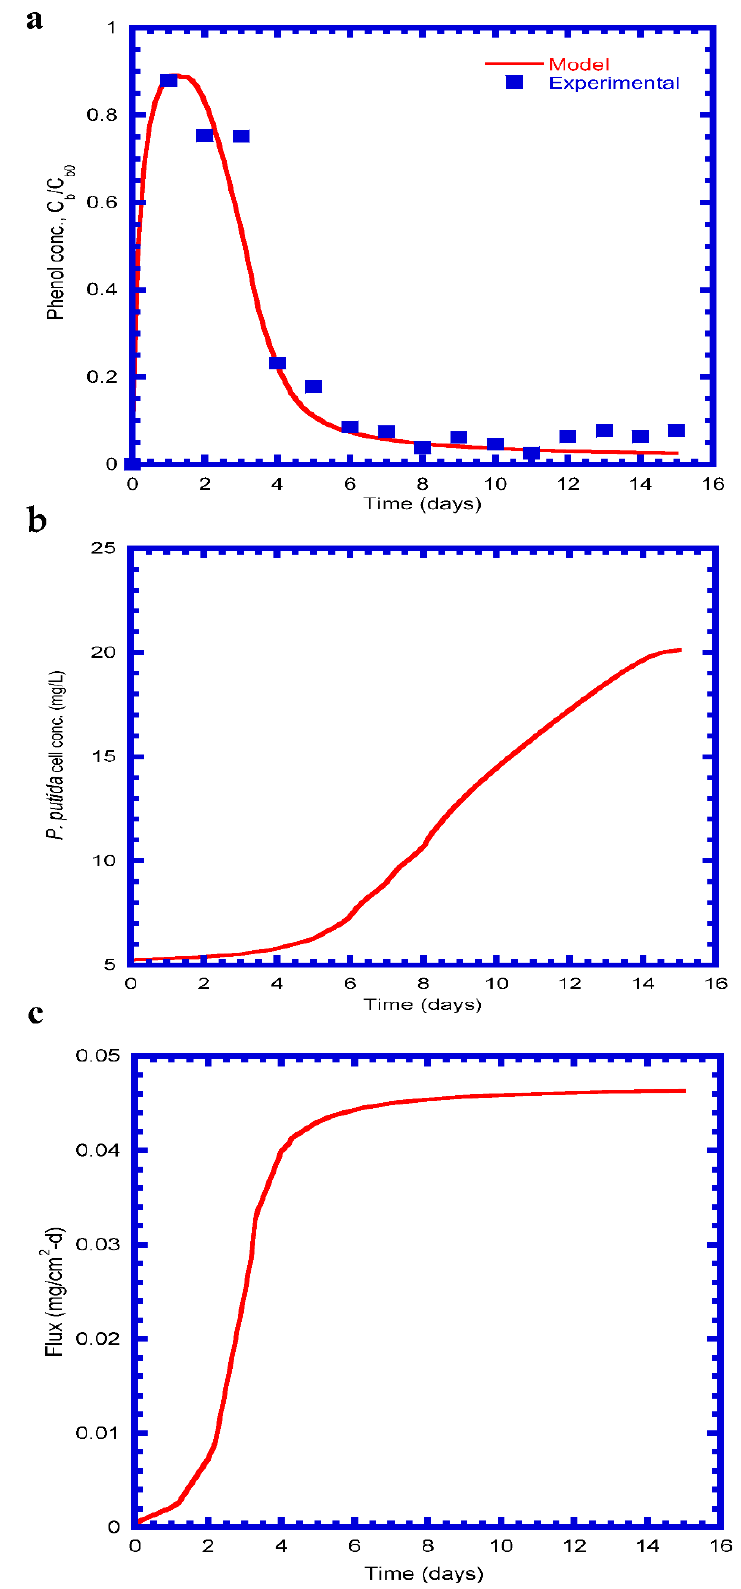
Figure 9. Model-predicted and experimental results in the continuous reactor: ( a ) phenol concentra- tion, ( b ) cell growth, and ( c ) flux into